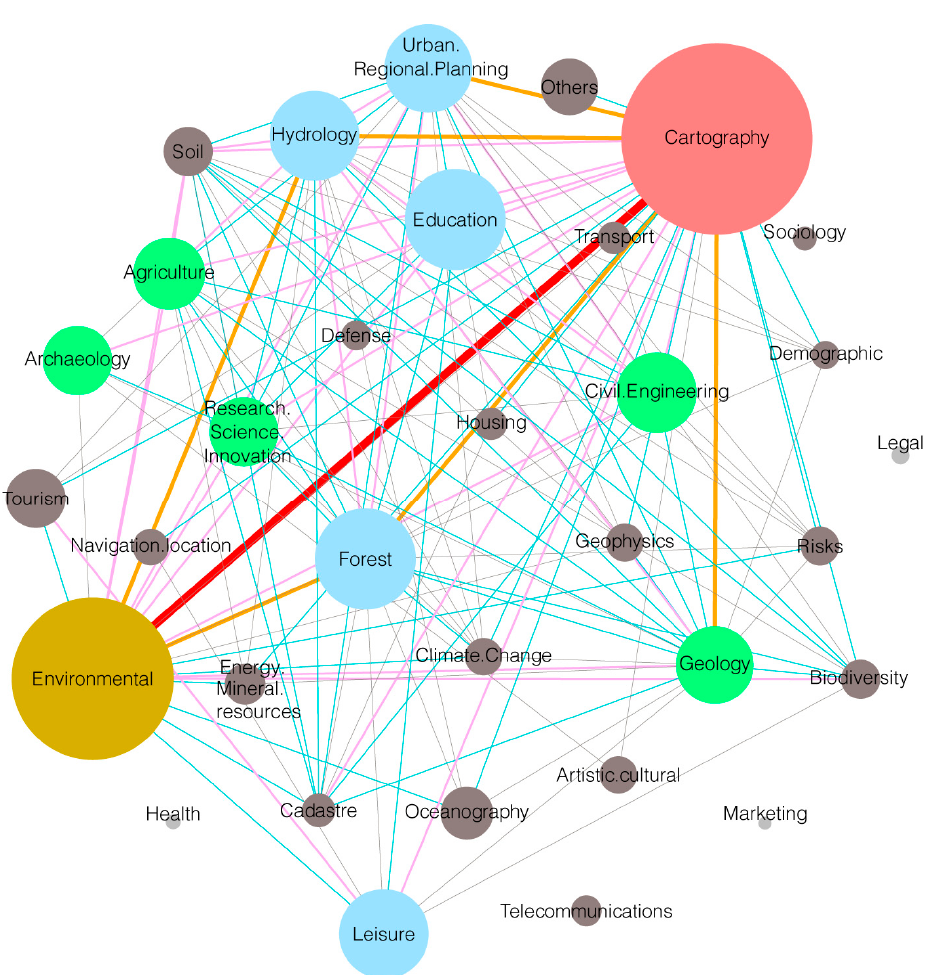
Figure 7. Thematic areas and their relations. ISPRS Int. J. Geo-Inf. 2017 , 6 , 406